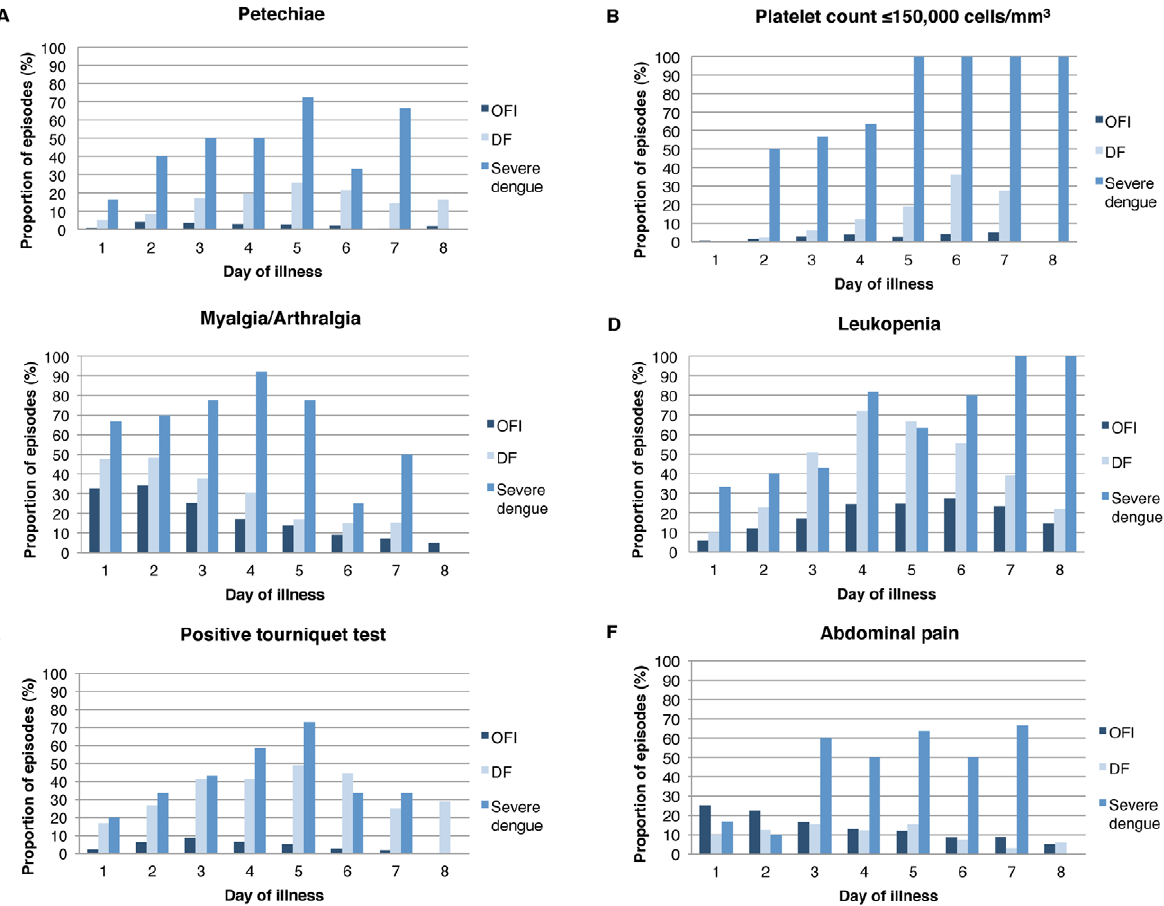
Figure 3. Frequency of signs and symptoms by day in patients with OFI, DF and severe dengue. Over the course of an episode of febrile illness, signs and symptoms were observed by medical personnel or reported by children and/or their parent/guardian. Selected signs and symptoms are shown here. A, Petechiae; OFI versus DF: chi-square test for trend 21.313, p , 0.0001; day 1, n=606; day 2, n=1,243; day 3, n=1,066; day 4, n=876; day 5, n=675; day 6, n=481; day 7, n=291; day 8, n=175; B, Platelet count # 150,000 cells/mm 3 ; OFI versus DF: chi-square test for trend 14.928, p=0.0001; day 1, n=604; day 2, n=970; day 3, n=615; day 4, n=568; day 5, n=348; day 6, n=234; day 7, n=122; day 8, n=65; C, Myalgia/ arthralgia; OFI versus DF: chi-square test for trend 4.569, p=0.03; day 1, n=612; day 2, n=1,253; day 3, n=1,075; day 4, n=877; day 5, n=671; day 6, n=477; day 7, n=289; day 8, n=181; D, Leukopenia; OFI versus DF: chi-square test for trend 6.449, p=0.01; day 1, n=604; day 2, n=971; day 3, n=615; day 4, n=568; day 5, n=348; day 6, n=234; day 7, n=122; day 8, n=65; E, Positive tourniquet test; OFI versus DF: chi-square test for trend 20.124, p , 0.0001; day 1, n=256; day 2, n=496; day 3, n=402; day 4, n=308; day 5, n=202; day 6, n=156; day 7, n=78; day 8, n=38; F, Abdominal pain; OFI versus DF: chi-square test for trend 9.149, p=0.002; DF versus severe dengue: chi-square test for trend 4.127, p=0.04; day 1, n=609; day